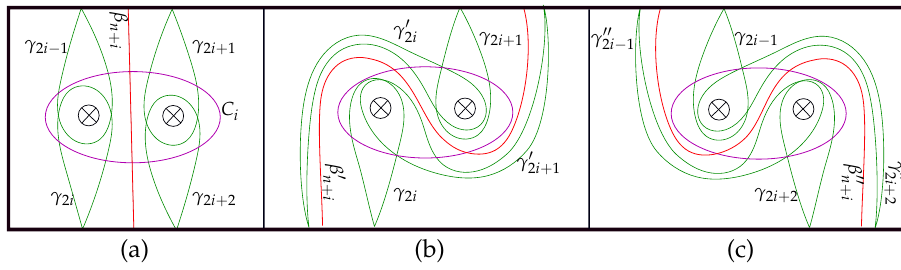
Figure 12. ( a ) A clover of type I, ( b ) a clover of type II, and ( c ) a clover of type